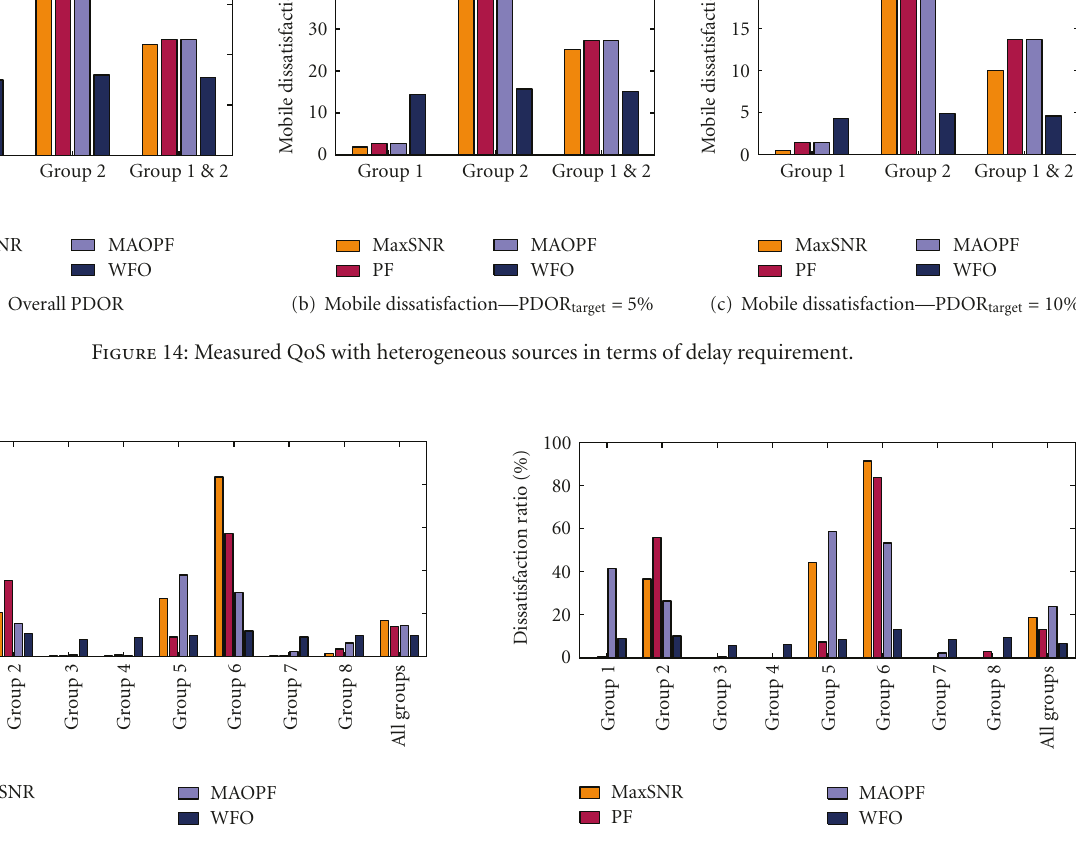
Figure 15: Overall PDOR. Figure 16: Mobile dissatisfaction when PDOR target =